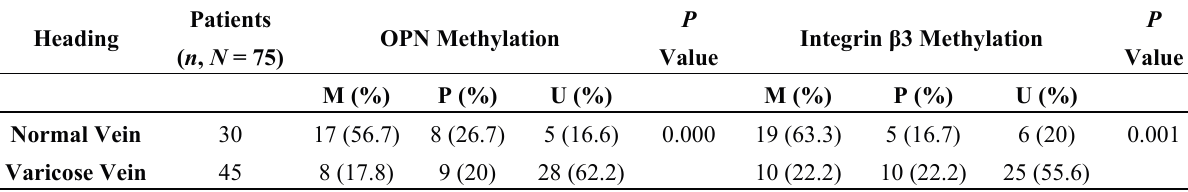
Table 1. Methylation levels of OPN and integrin β 3 in different vein